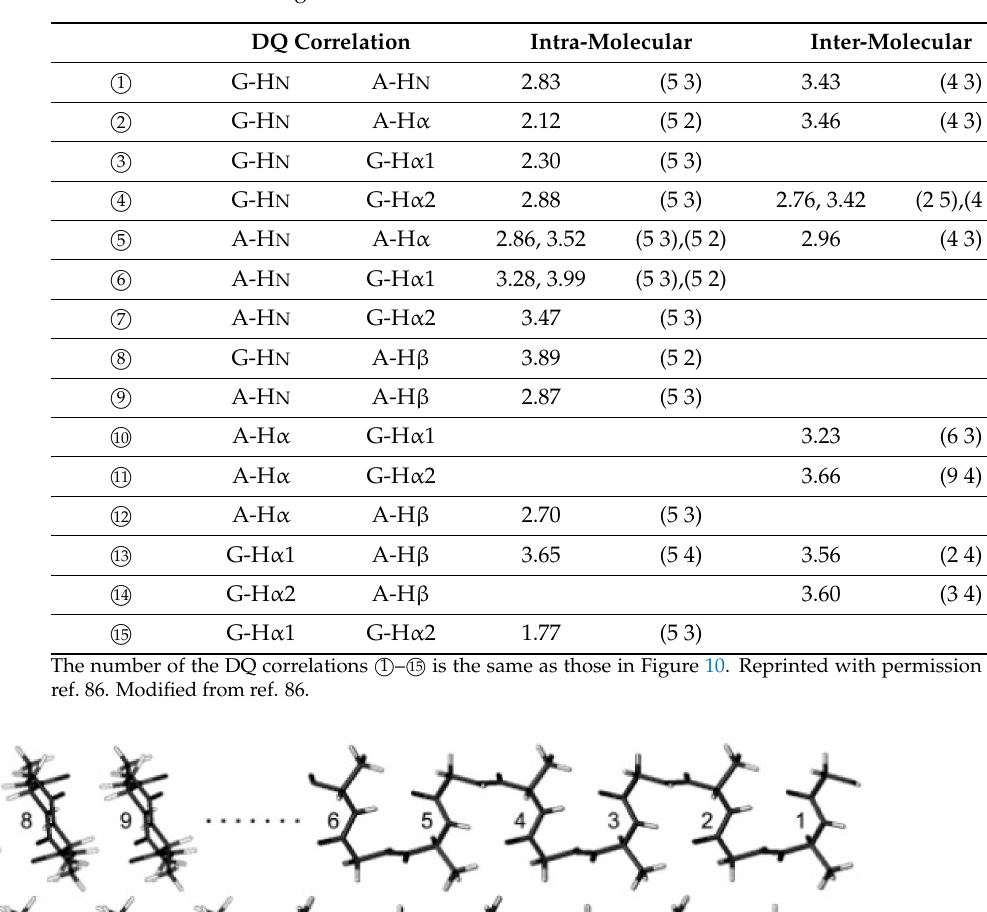
Table 2. The intra- and intermolecular 1 H- 1 H distances (in Å) of (AG) 15 molecules with type II β -turn structure calculated using the coordinates of 1 H atoms obtained from the CASTEP calculation.